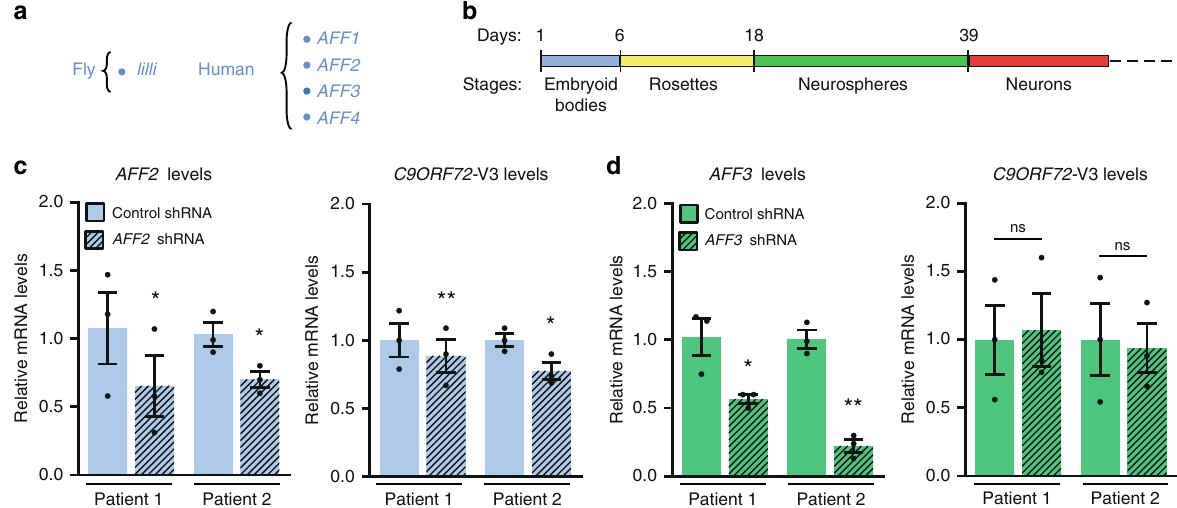
Fig. 6 The effect of knockdown of AFF family members on C9ORF72 expression in human neurons. a Corresponding human homologues of Drosophila lilli . b Schematic representation of the neuron differentiation protocol used in this study. Human neurons derived from two C9ORF72 patient iPSC lines were transduced with lentiviruses containing AFF2 -speci fi c ( c ) or AFF3 -speci fi c ( d ) shRNAs, cultured for 10 days, and analyzed for expression of AFF2 , AFF3 , and C9ORF72 -V3 mRNAs. Each data point represents one differentiation ( n = 3 independent differentiations). Values are mean ± s.e.m. ns, not signi fi